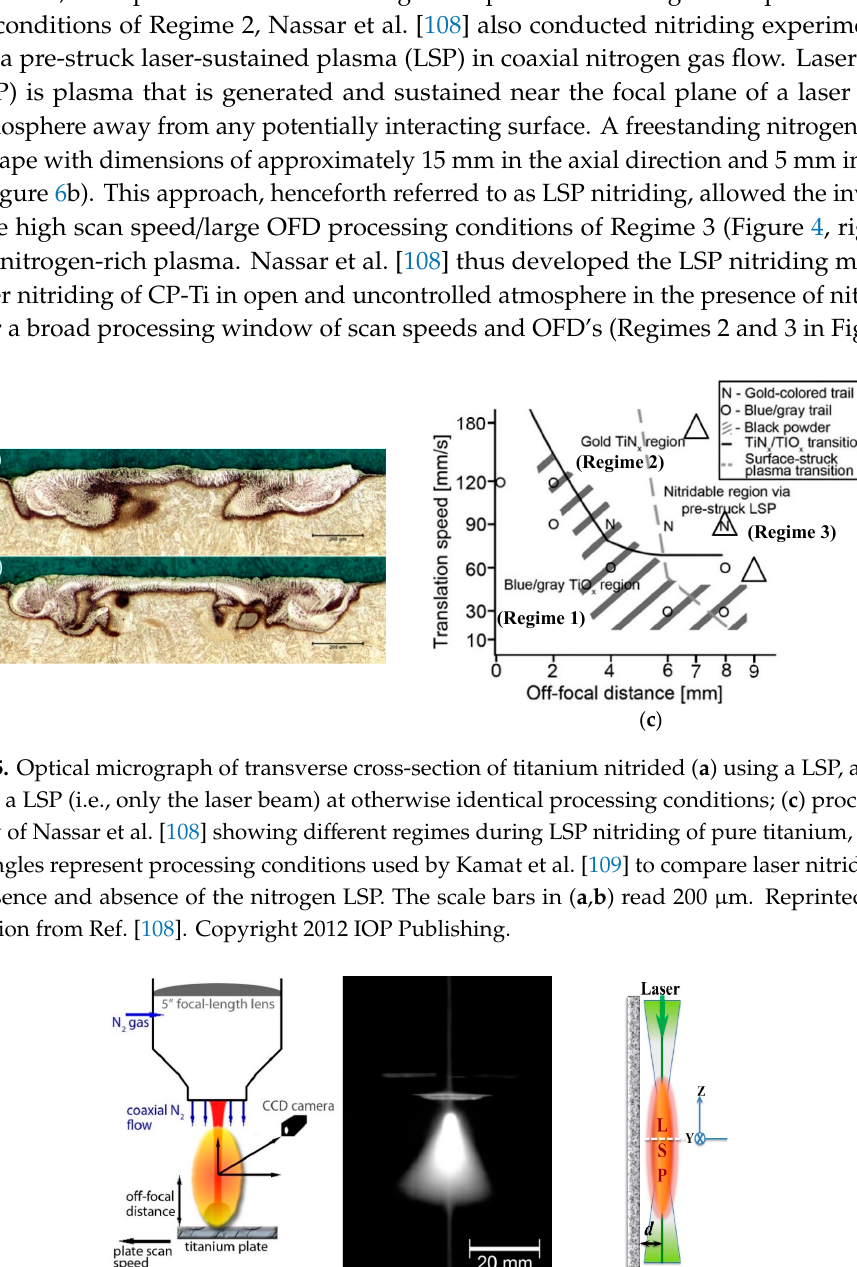
Figure 6. ( a ) Schematic of Nassar et al.’s [108] LSP nitriding process with the substrate perpendicular to the laser beam, ( b ) CCD image of freestanding nitrogen LSP, and ( c ) schematic of Black et al.’s [111] LSP nitriding process with the substrate parallel to the laser beam. Figure 6a,b reprinted with permission from Ref. [108]. Copyright 2012 IOP Publishing. Figure 6c reprinted with permission from Ref. [111]. Copyright 2017 Elsevier.